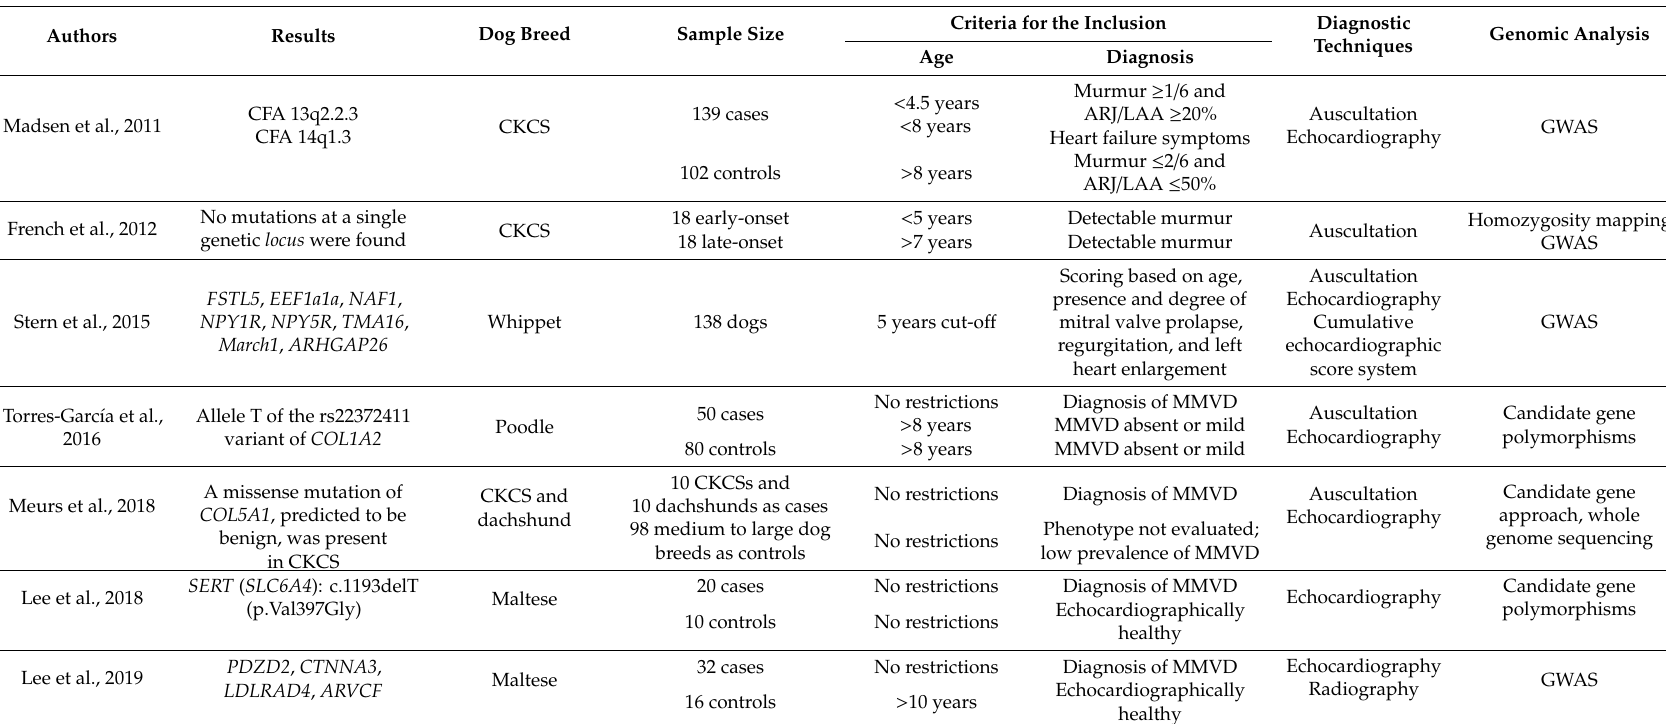
Table 1. Summary of previous genomic studies about myxomatous mitral valve degeneration